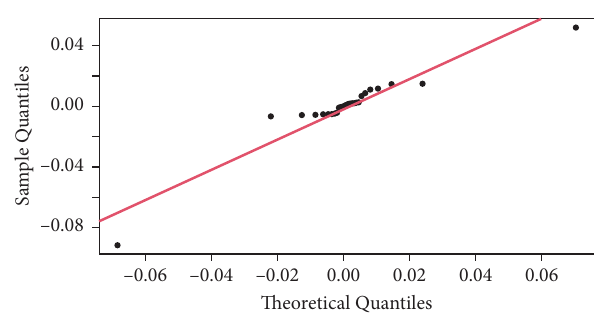
Figure 5: Cauchy Q-Q plot of real